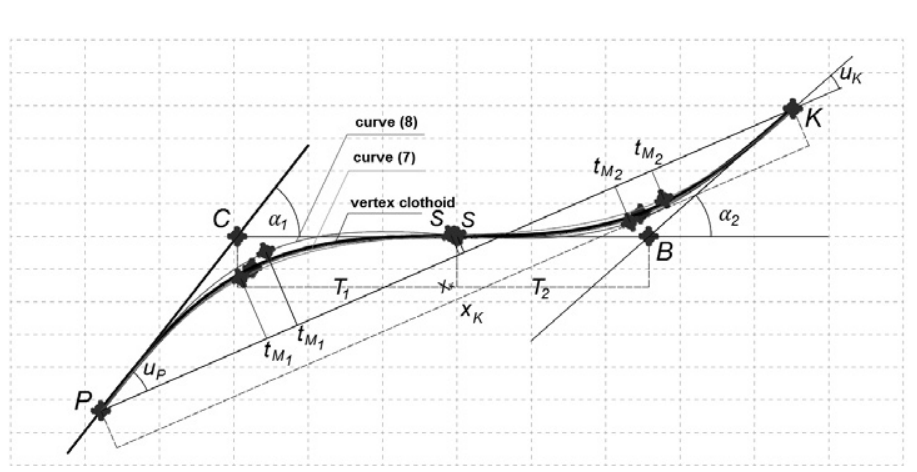
Figure 7. Reverse curves: symmetric vertex clothoids vs S -shaped transition curves (variant